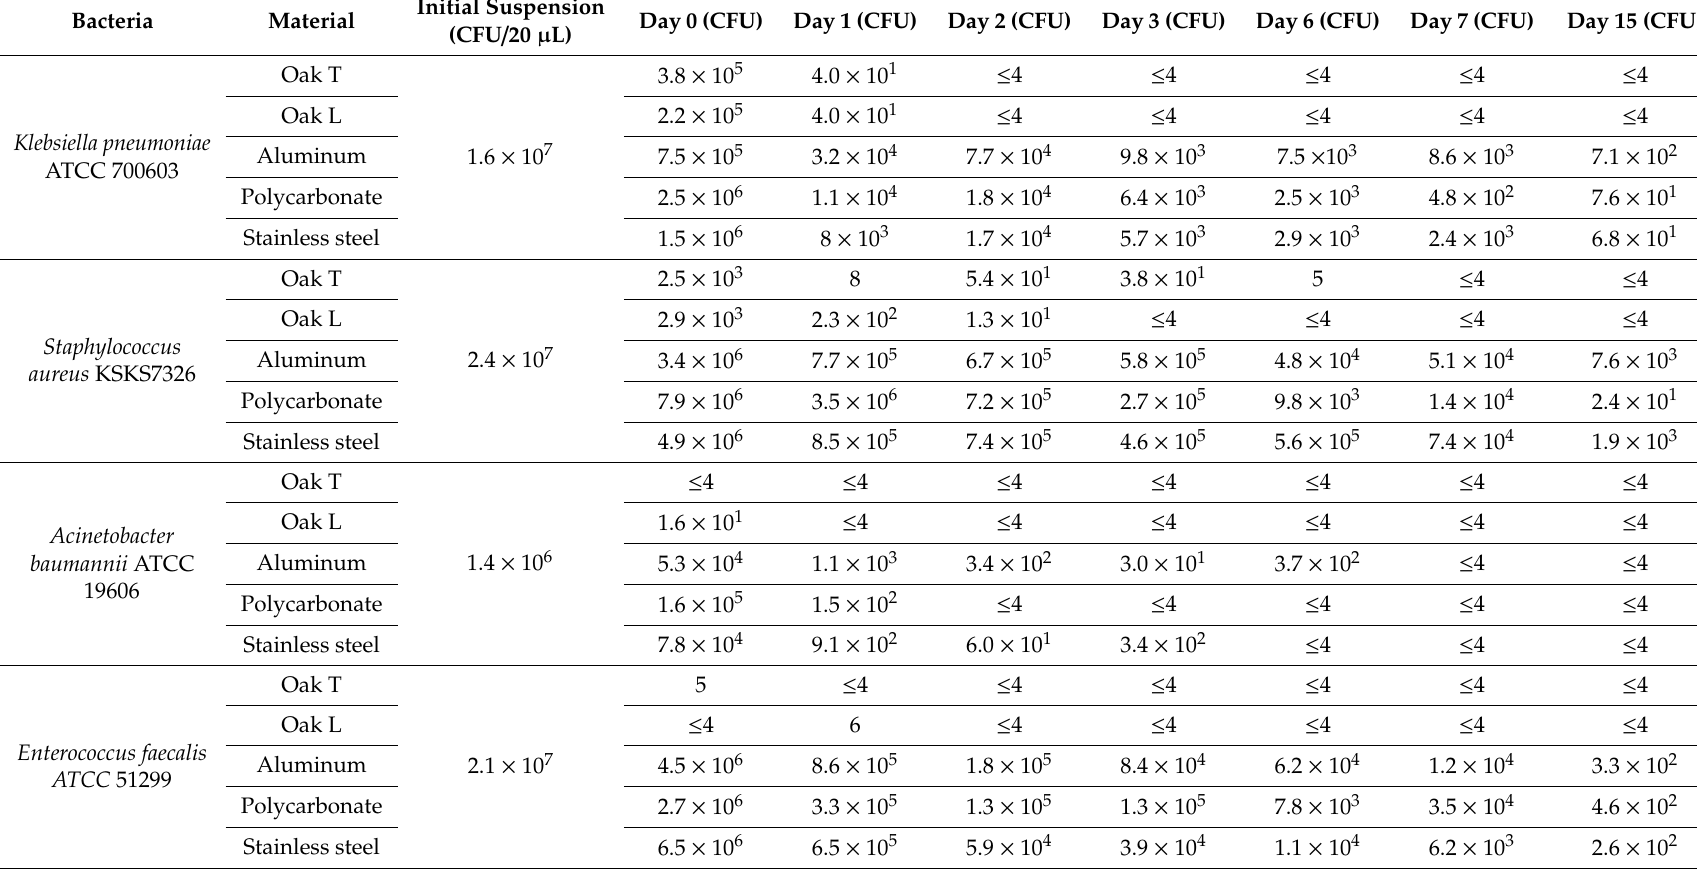
Table 1. Viable counts of Klebsiella pneumoniae American Type Culture Collection (ATCC) 700603, Staphylococcus aureus KSKS7326, Acinetobacter baumannii ATCC 19606, and Enterococcus faecalis ATCC 51299 on the di ff erent materials